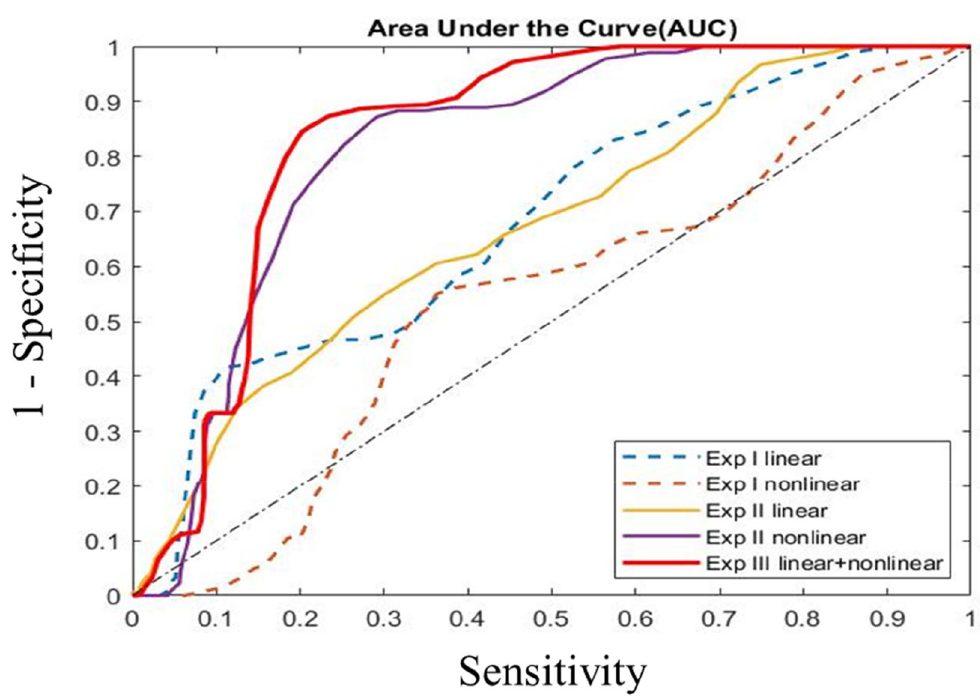
Figure 3. ROC curves depicting AUC from all three experiments I, II, and III. AUC for the three sets of experiments, clearly showing the outperformance from the RF model on linear and nonlinear